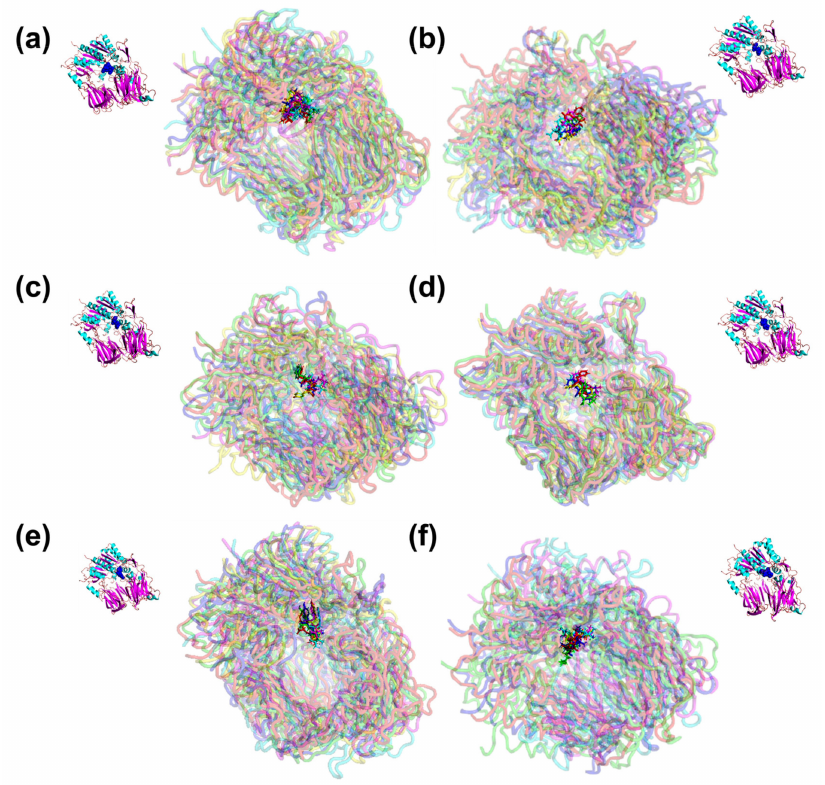
Figure 5. Snapshot of the superimposed structures of DPP-IV in complex with peptide ( a ) Diprotin A, ( b ) TF, ( c ) TY, ( d ) VF, ( e ) VY and ( f ) IAL. Structures were obtained from the trajectory file in the interval of 5 ns for 25